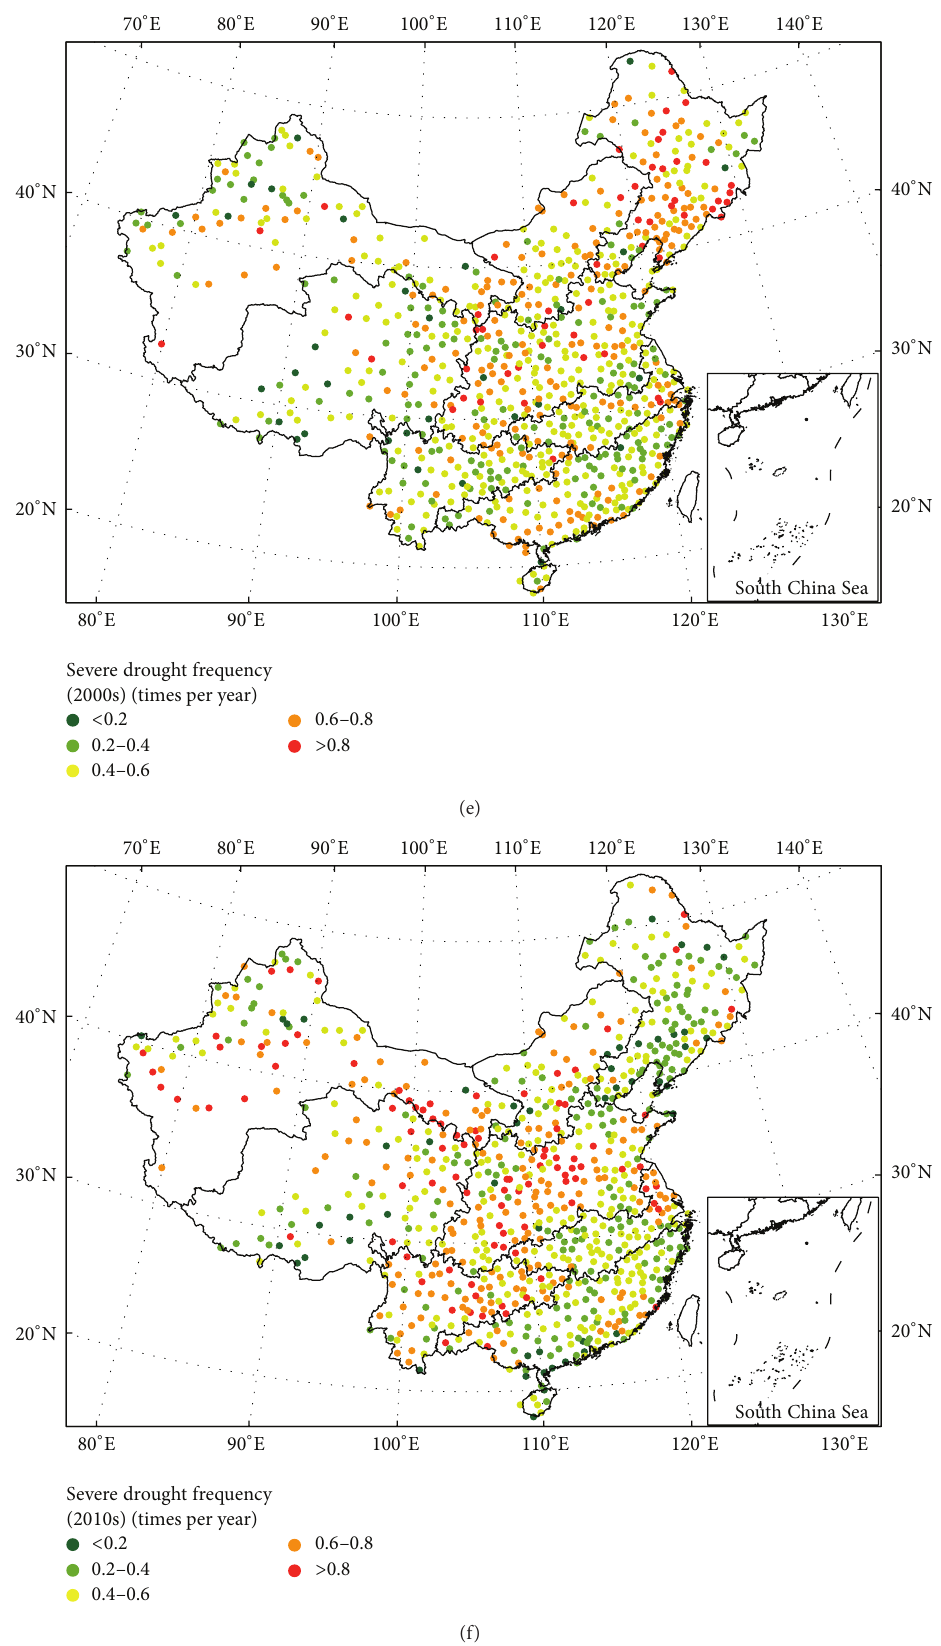
Figure 8: Decadal variation of severe drought frequency over China: (a) 1960s; (b) 1970s; (c) 1980s; (d) 1990s; (e) 2000s; (f)